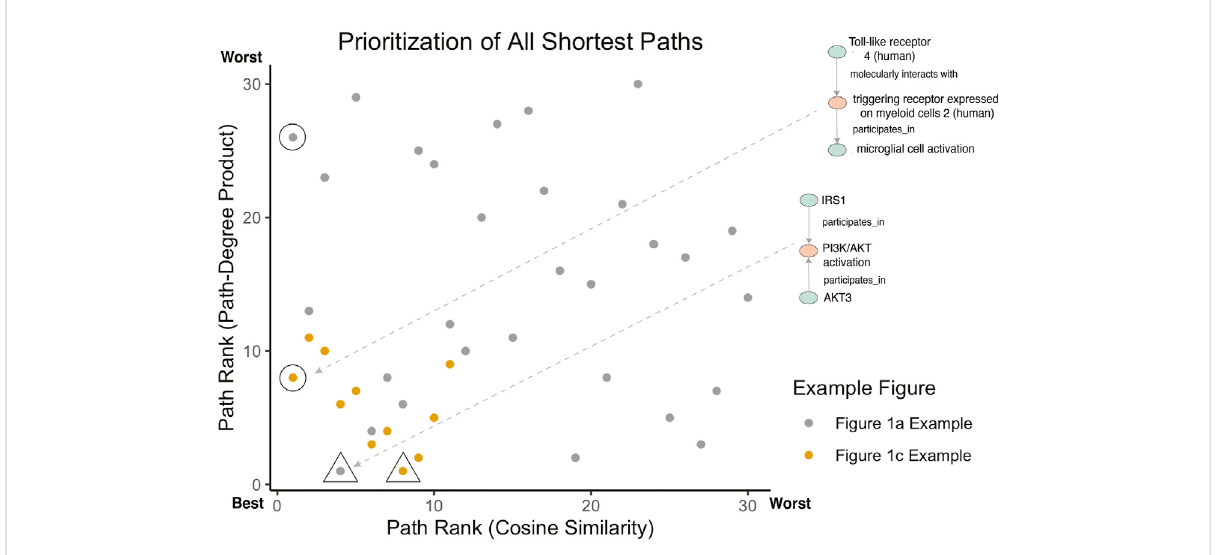
FIGURE 6 Comparison of path prioritization algorithms. For the Figure 1A example, the rank of all paths between IRS1 and AKT3 is shown (as depicted in Figure4A).FortheFigure1Cexample,therankofallpathsbetweenToll-likereceptor4(human)andmicroglialcellactivationisshown(asdepictedin Figure 4B). Annotated points identify the highest ranked path for Cosine Similarity (circles) and Path-Degree Product (triangles) to highlight the differences in ranking. The Figure 1B example is not included as all pairs had only between 1 and 2 shortest